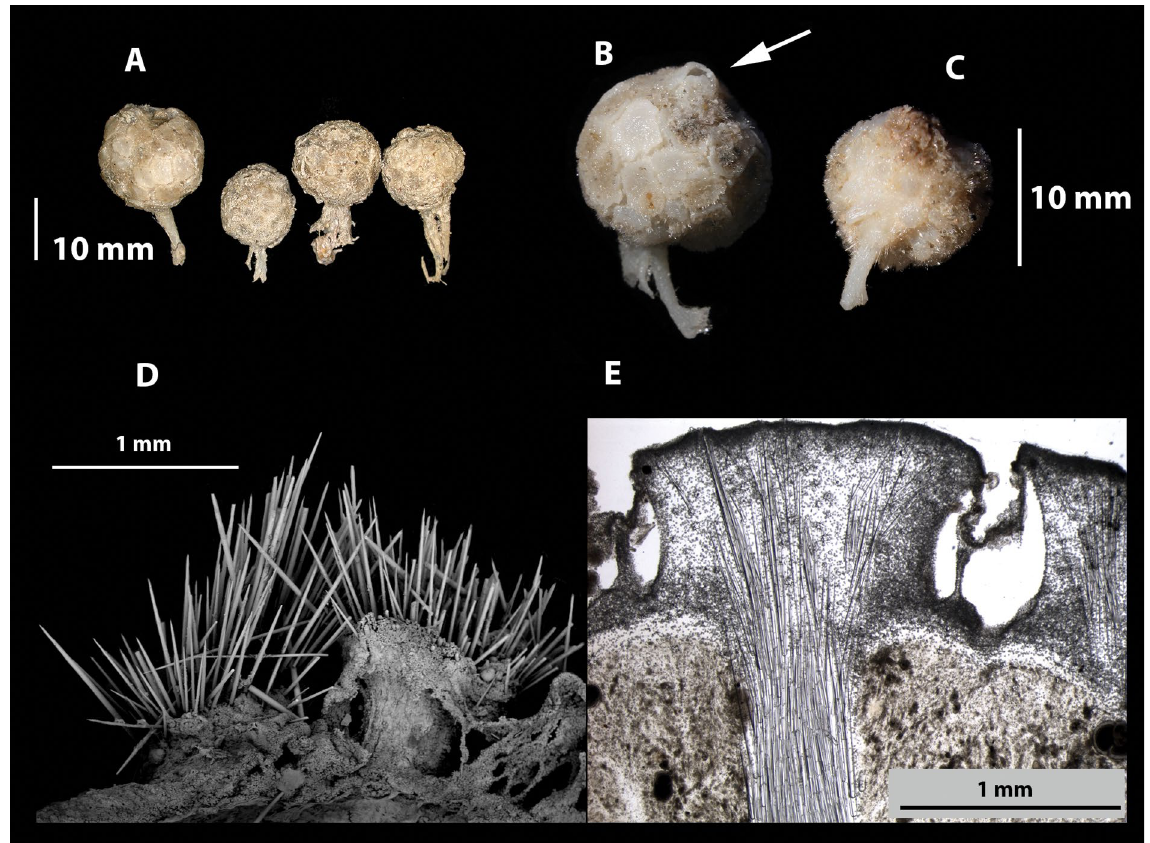
Fig. 2. A . Freshly collected specimens (lot SAMA S2096) of Tethya irisae sp. nov. B . Paratype (QM G305000) showing single apical oscule (arrow), and tessellated plate-like polygonal tubercules. C – D . Holotype (SAMA S3387), entire specimen and SEM showing surface tubercules with emerging megascleres. E . Section of UPSZTY 178608, showing the well-developed cortex and cortical canals around the